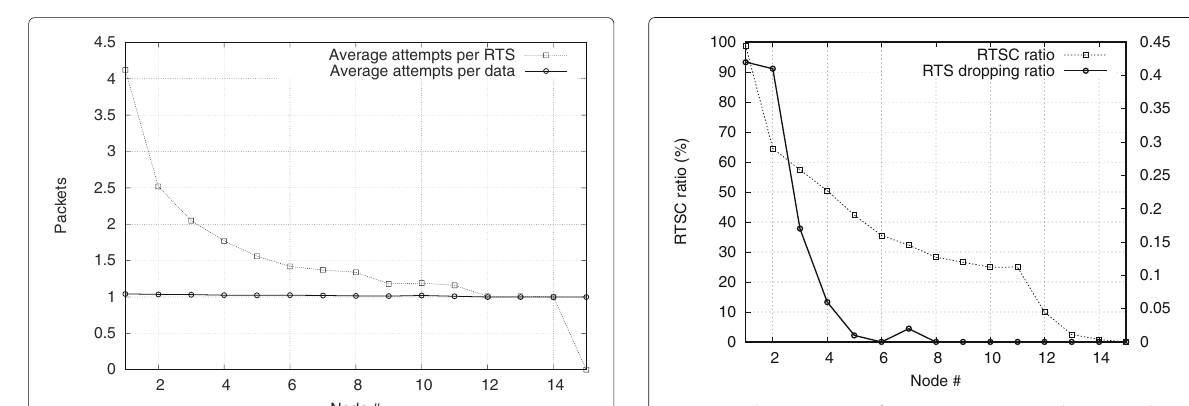
Fig. 4 RTS dropping ratio after seven attempts and RTSC sending